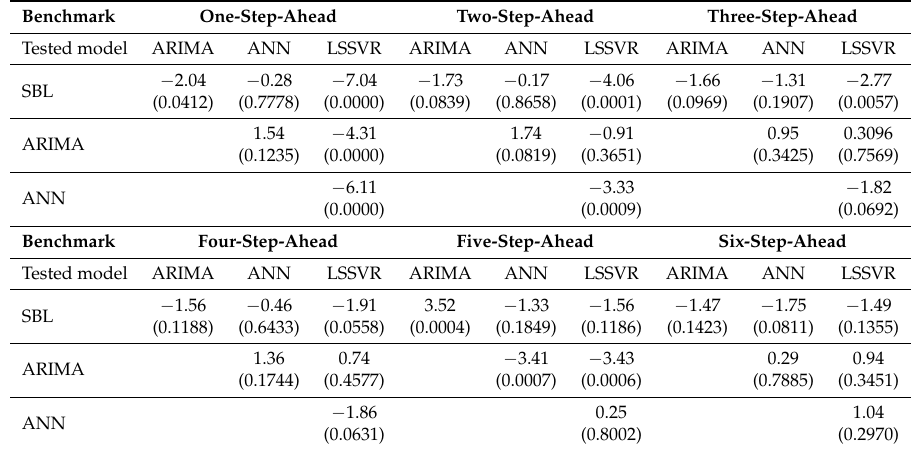
Table 5. The DM test results for single models on Brent crude oil prices.